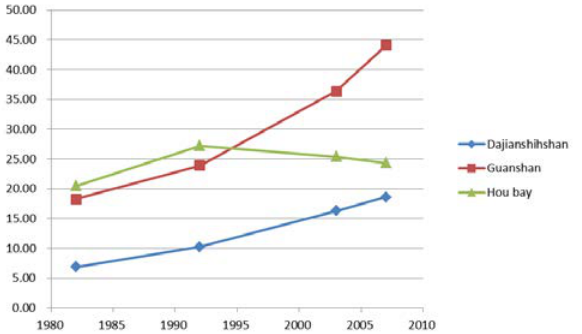
Fig. 3. Leucaena Leucocephala distributed in each study area of different year Table 3 Leucaena Leucocephala distributed in each study area of different year